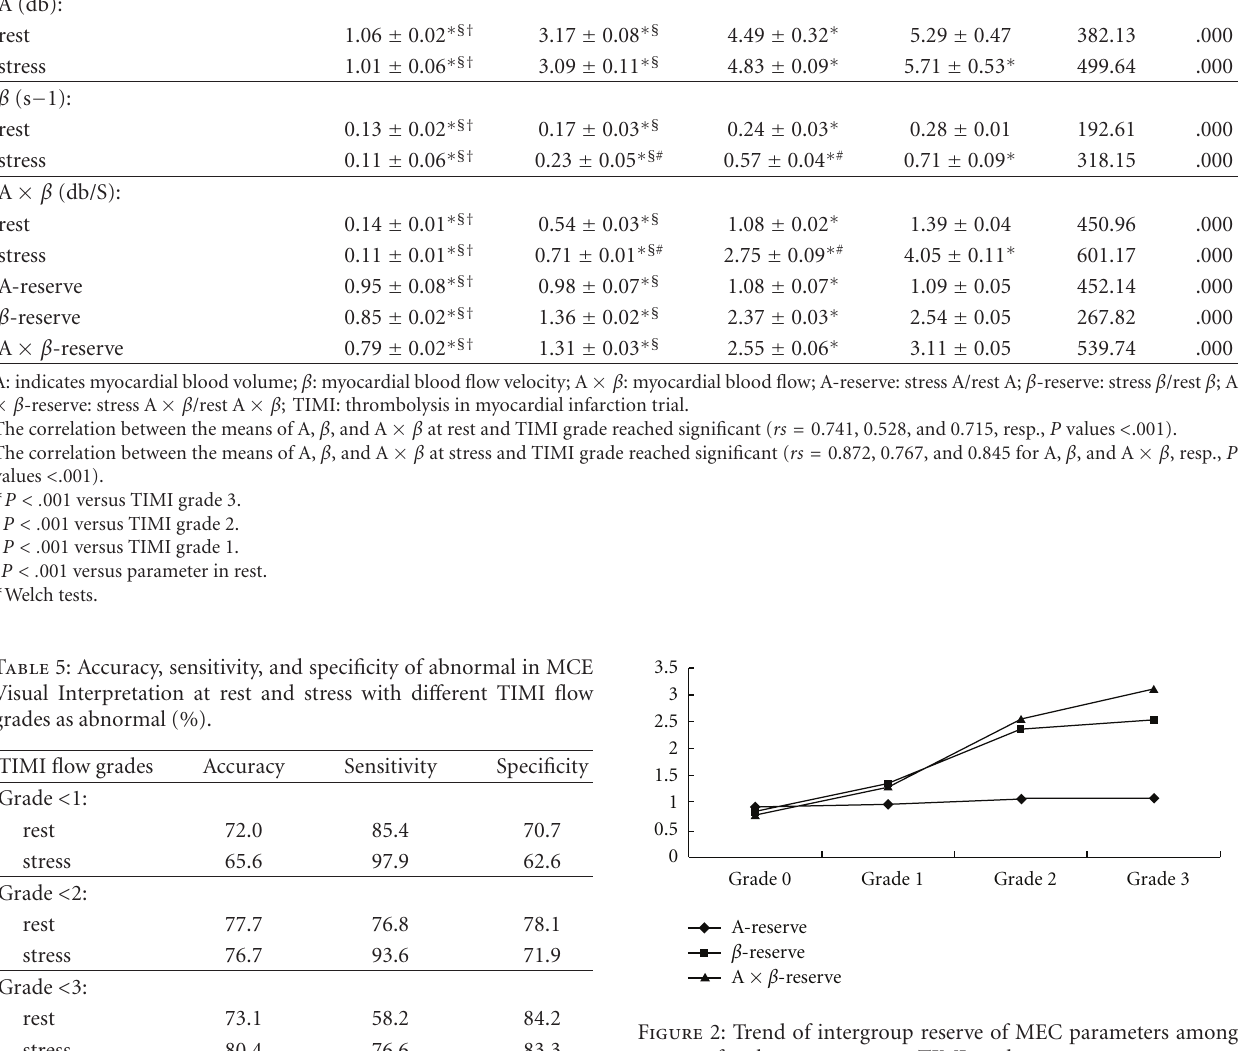
Table 4: Comparison of myocardial perfusion parameters at rest and stress among TIMI flow grades. Myocardial perfusion parameters